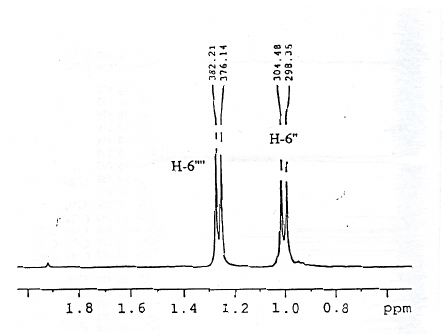
Figure S2 . 1 H-NMR spectrum of sagittatin A (300 MHz; CD 3 OD). Magnification of 0.5 – 1.0 Figure S2: 1 H-NMR spectrum of sagittatin A (300 MHz; CD 3 OD). Magnification of 0.5 -1.0 ppm ppm region.